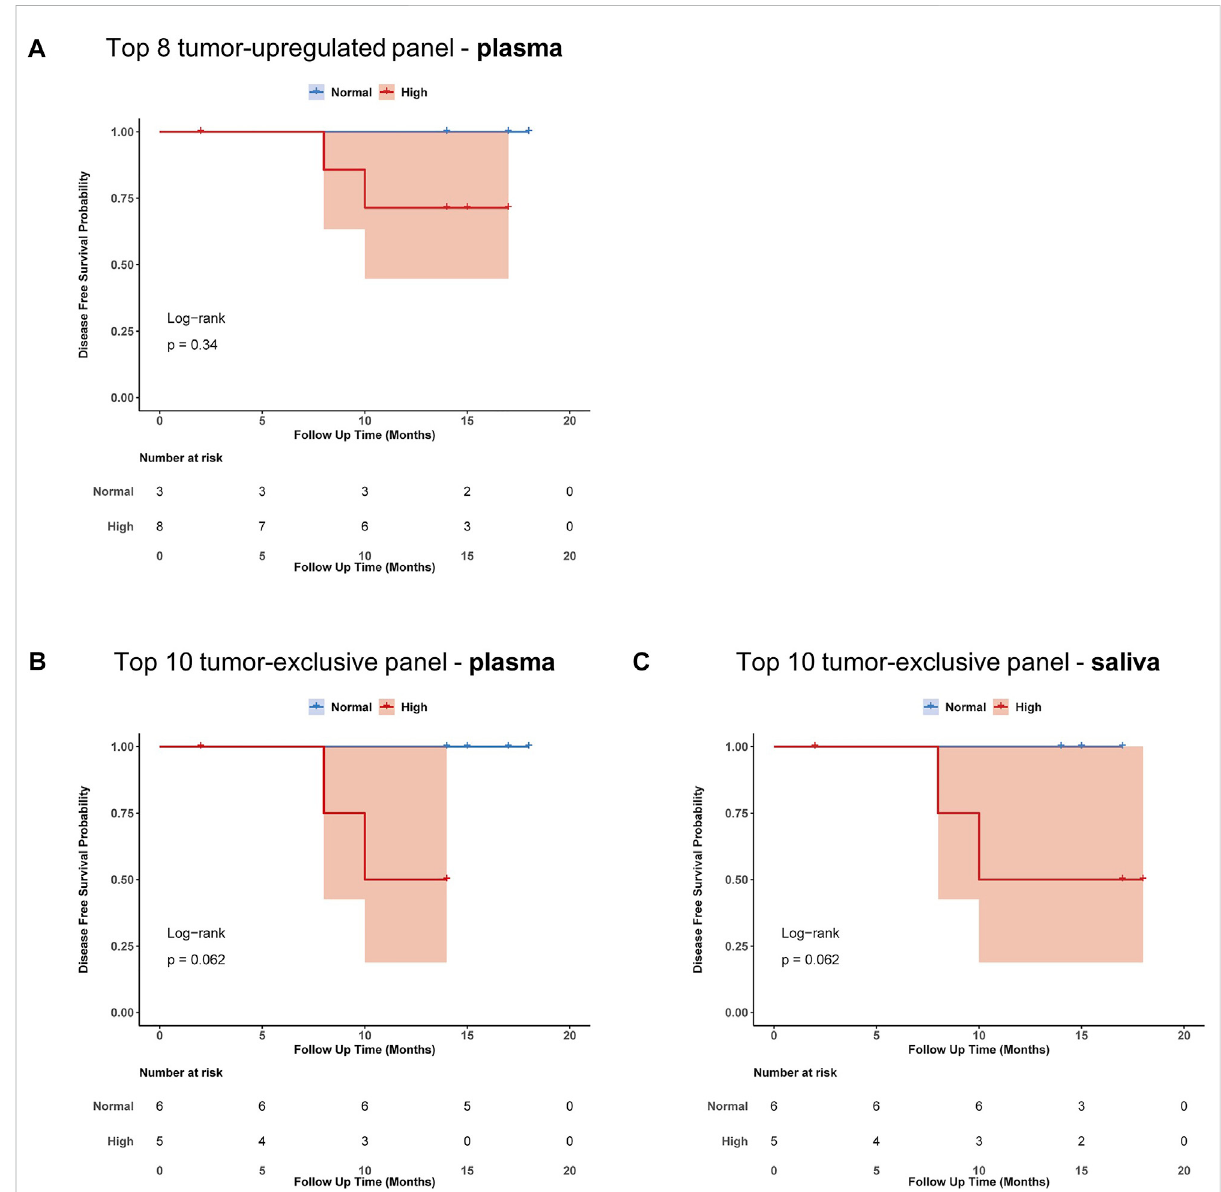
FIGURE 6 Prognostic impact of proposed exosome-based miRNA panels from plasma and saliva. Kaplan-Meier plots with log-rank test for disease-free survival (DFS)ofHNSCC-patients binarized according totheirexpressionofmiRNAs present in (A) tumor-upregulatedpanelfromplasma (B) tumor- exclusive panel fromplasmaand (C) tumor-exclusive panelfrom saliva.Blueindicates normal expression,redindicateshighexpression,shadedarea indicates the con fi dence